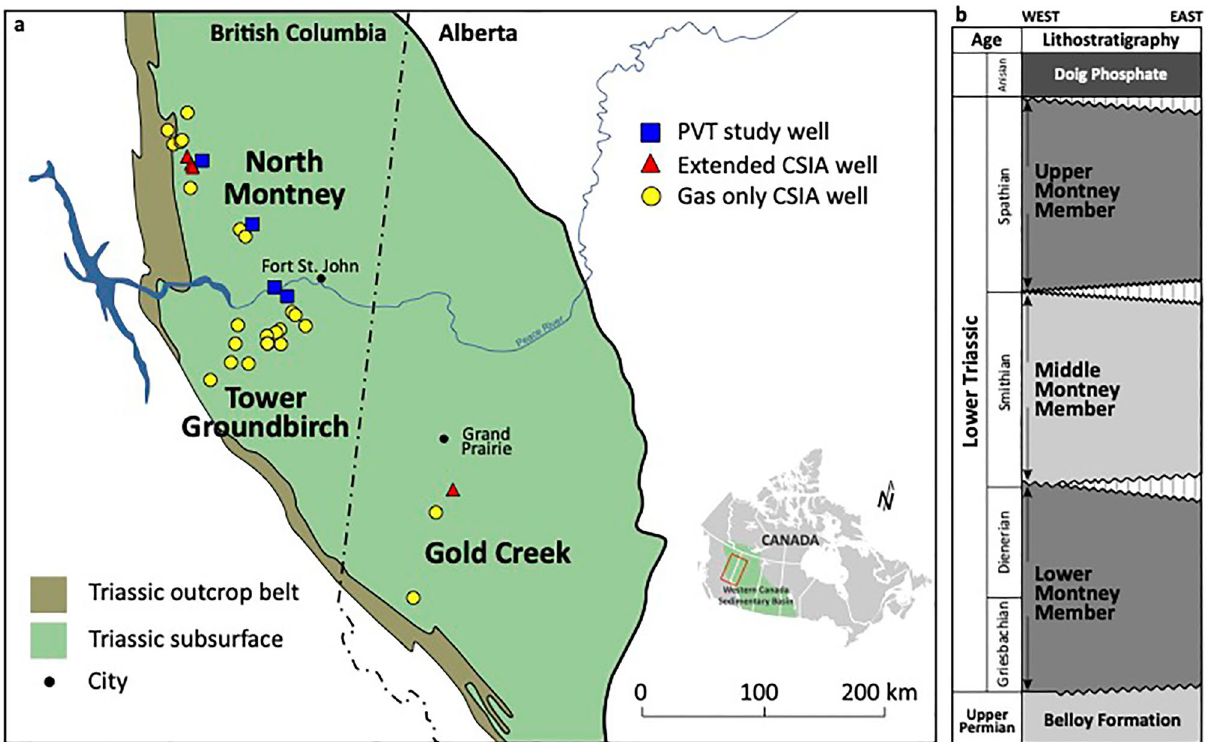
Figure 1. Geographic and stratigraphic setting of the Montney unconventional petroleum system. ( a ) Map showing the location of the Montney unconventional petroleum system and the three geographic study areas at North Montney, Tower-Groundbirch and Gold Creek. Symbols show locations of wells with data used in this study; PVT recombination PVT compositional data, CSIA compound-specific isotope analysis. Modified from Zelazny et al. 69 . Used with permission of CSPG. ( b ) Stratigraphic column showing relationships of the Montney Formation and its three main constituent members (Lower, Middle, Upper). Modified from Zonneveld and Moslow 28 . Used with permission of